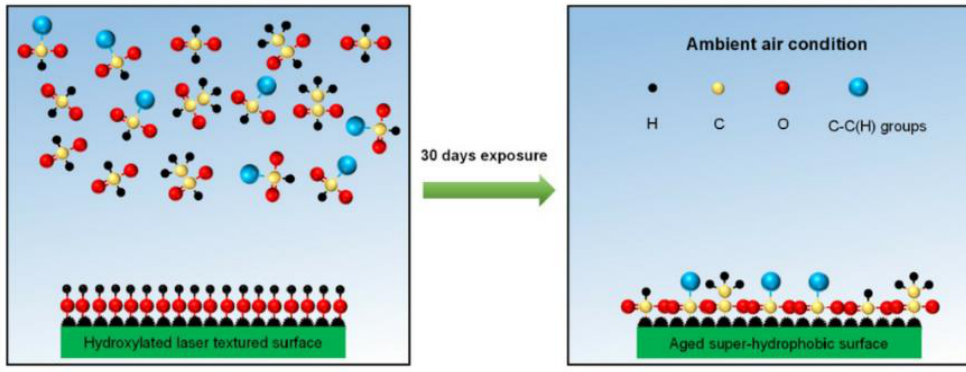
Figure 7. Schematic diagram of chemical adsorption mechanism during placement (Reprinted with permission from Ref. [30]. 2018, Yang, Z.).